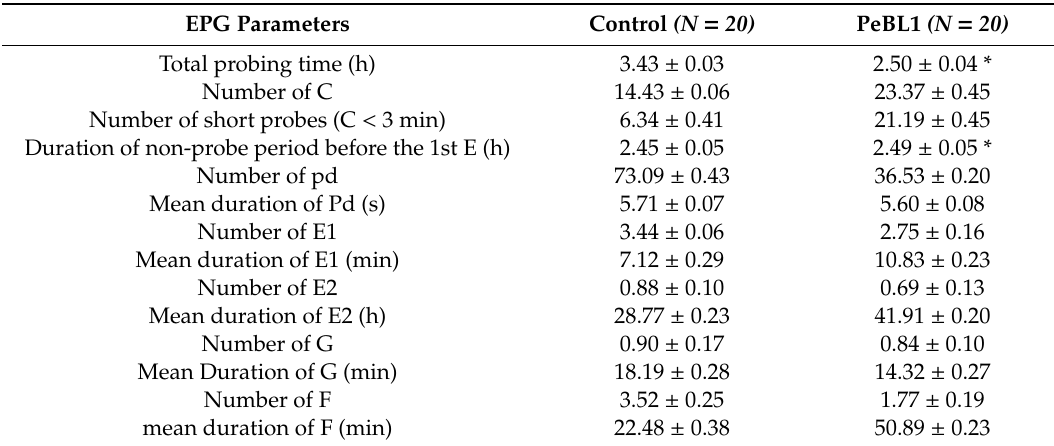
Table 3. Electrical penetration graph (EPG) data of M. persicae on PeBL1-treated and control cucumber